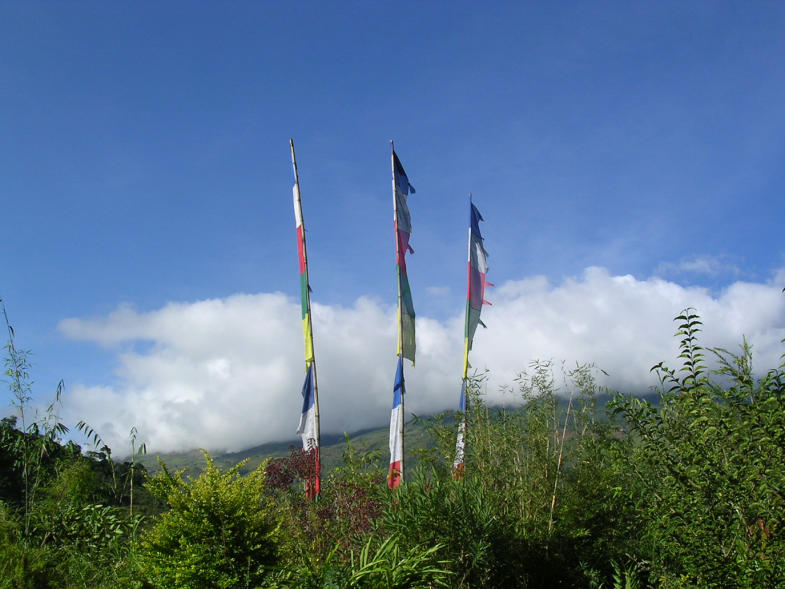
Prayer flags in the valley of Katmandu, Nepal